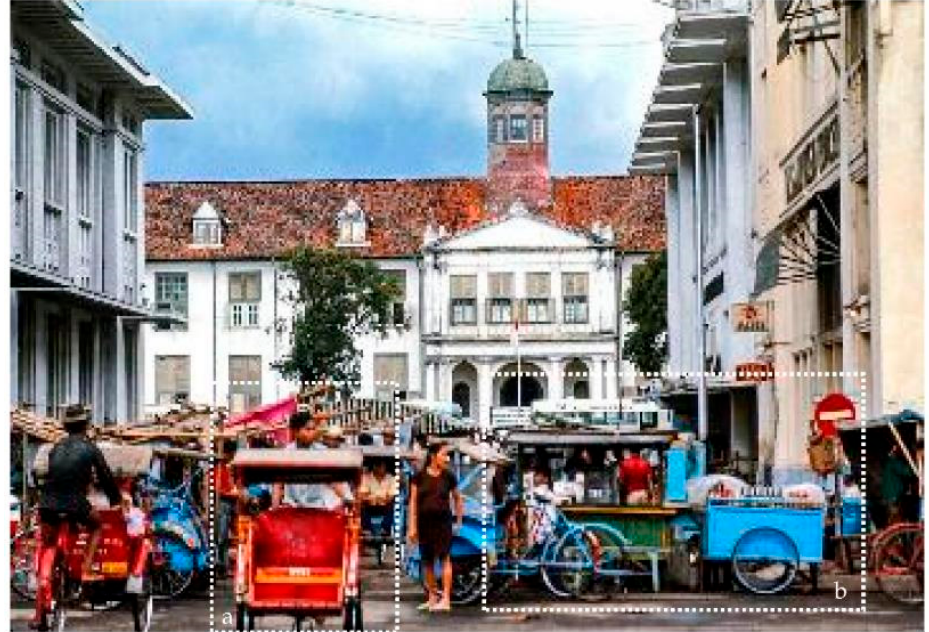
Figure 13. The street hawkers, food stalls and rickshaws at the Fatahillah Square. Identified sound sources: ( a ) rickshaws ( b ) street hawkers. Source: Eugene Cosserat-Flickr.